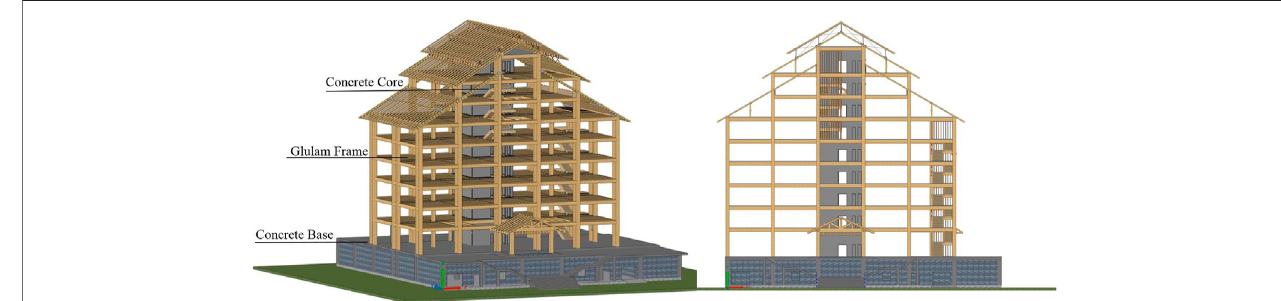
FIGURE 1 | Sketch of 10 storey timber-concrete hybrid building.